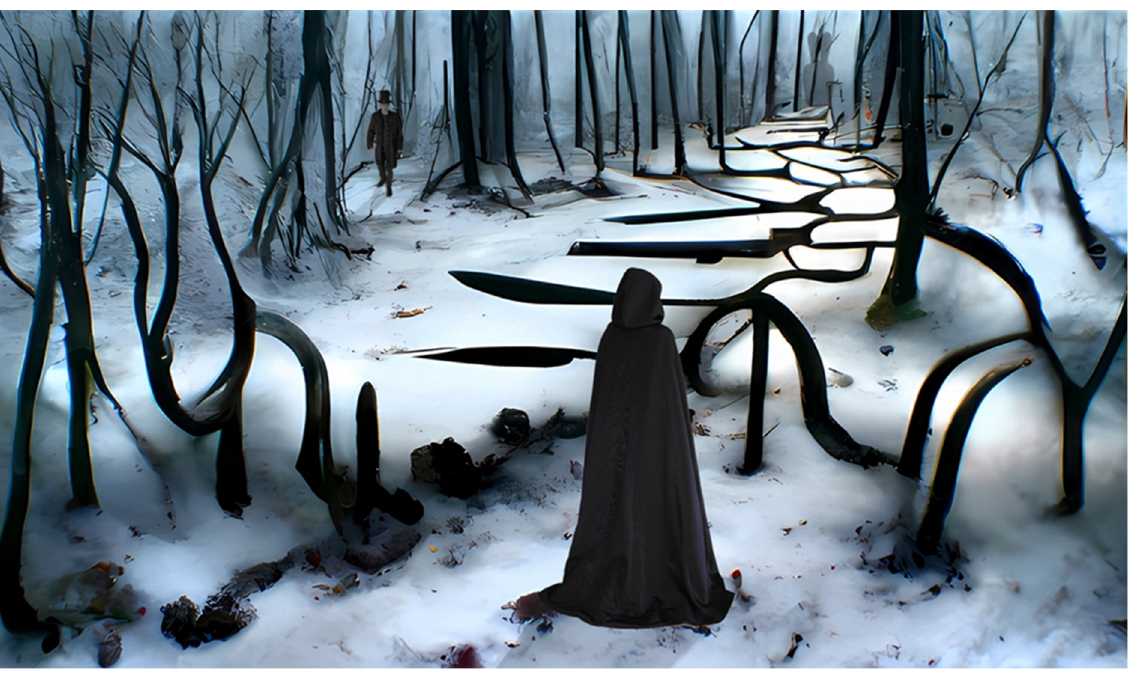
Figure 2. Madeleine + Two roads diverged in a wood, and I… By Graeme Revell, 2022. Photograph, GPT-2/DALL-E2 image and text. GPT-2/DALL-E2 image and